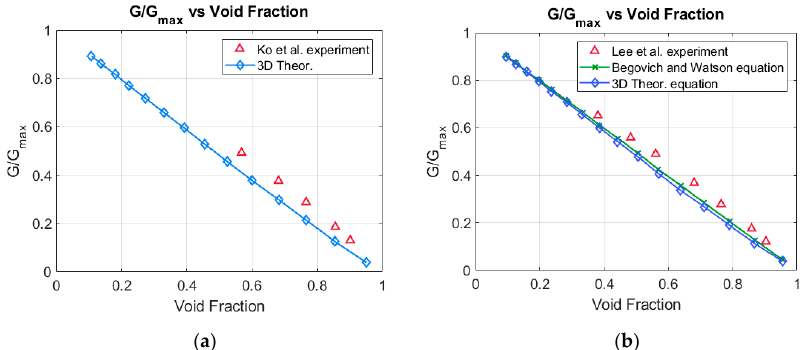
Figure 11. ( a ) G/Gmax versus the void fraction for the experiments performed by Ko et al. [12], displayed in the upper line and the calculations performed with Equation (19), displayed in the lower line. ( b ) G/Gmax versus the void fraction for the experiments performed by Lee et al. [13], upper-line and the calculations performed with Equation (19), lower line, the middle line are the results obtained using the Begovich and Watson equation [6].